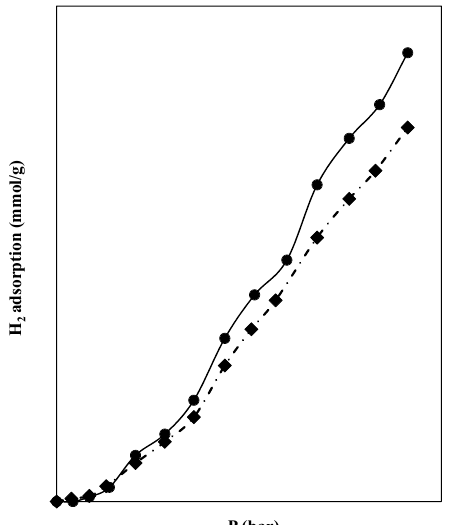
Fig. 6. Hydrogen adsorption isotherms of the graphene oxide ( ■ ) and g-C